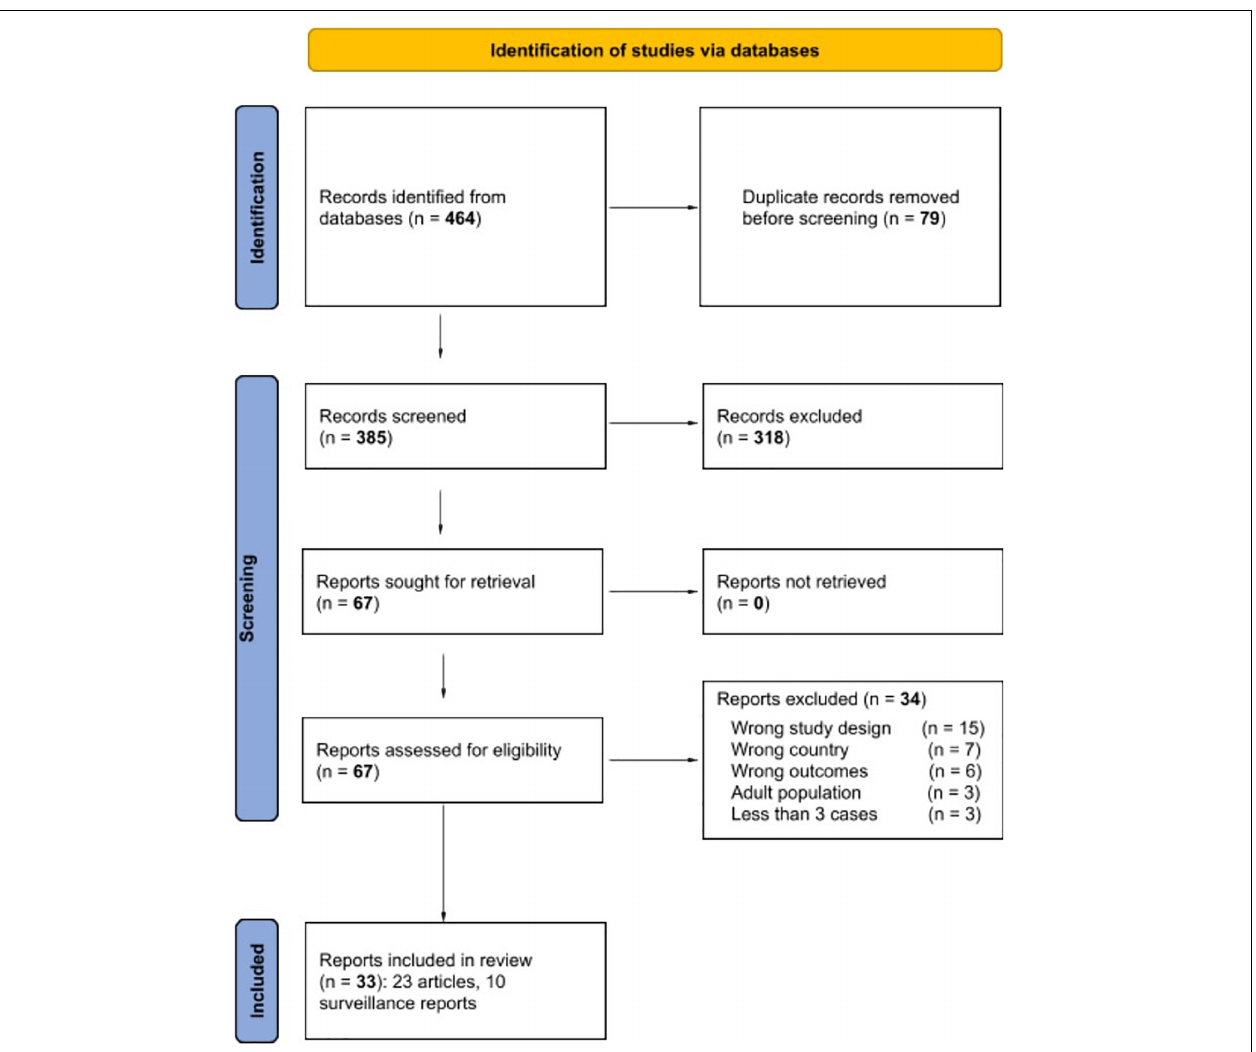
FIGURE 1 | PRISMA 2020 study flow diagram. The PRISMA 2020 checklist and the evidence quality scores of the articles included (risk of bias) can be found in Supplementary Table 1